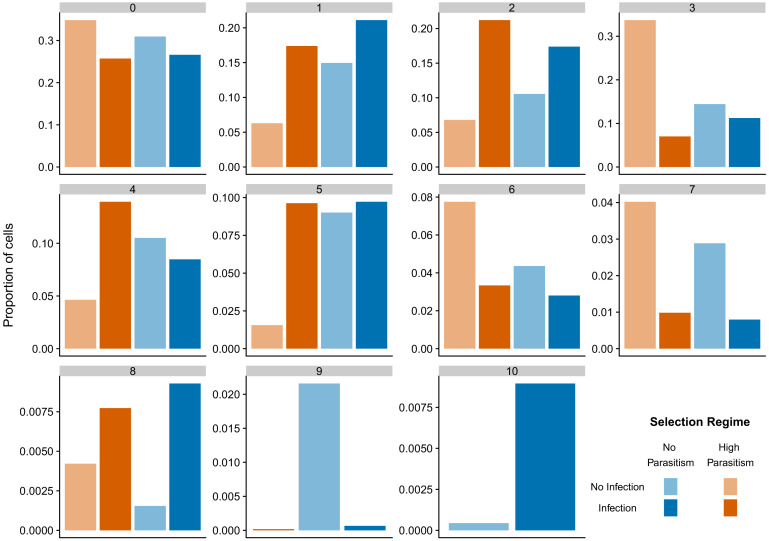
Proportion of different cell states after infection and selection following data integration with 7716 anchors, the maximum number that can be detected.